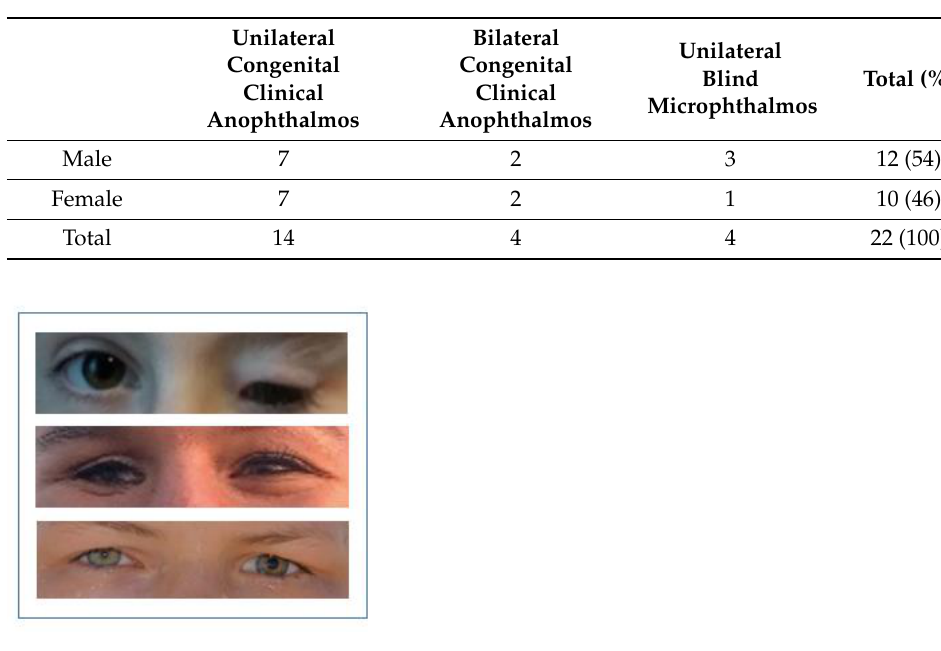
Table 1. Classification of the study population with regard to their disease.